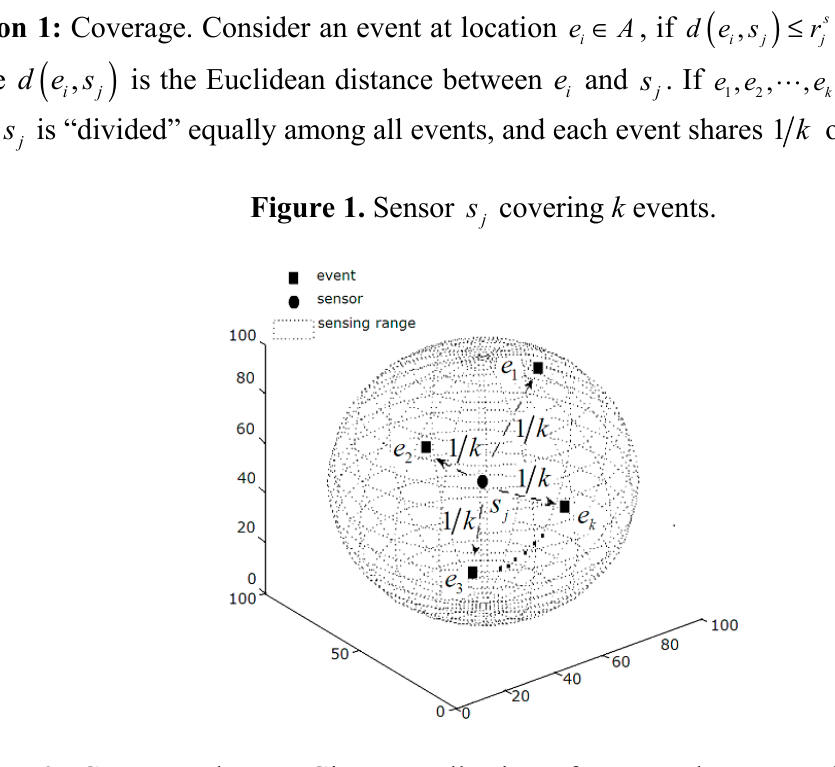
Figure 1. Sensor